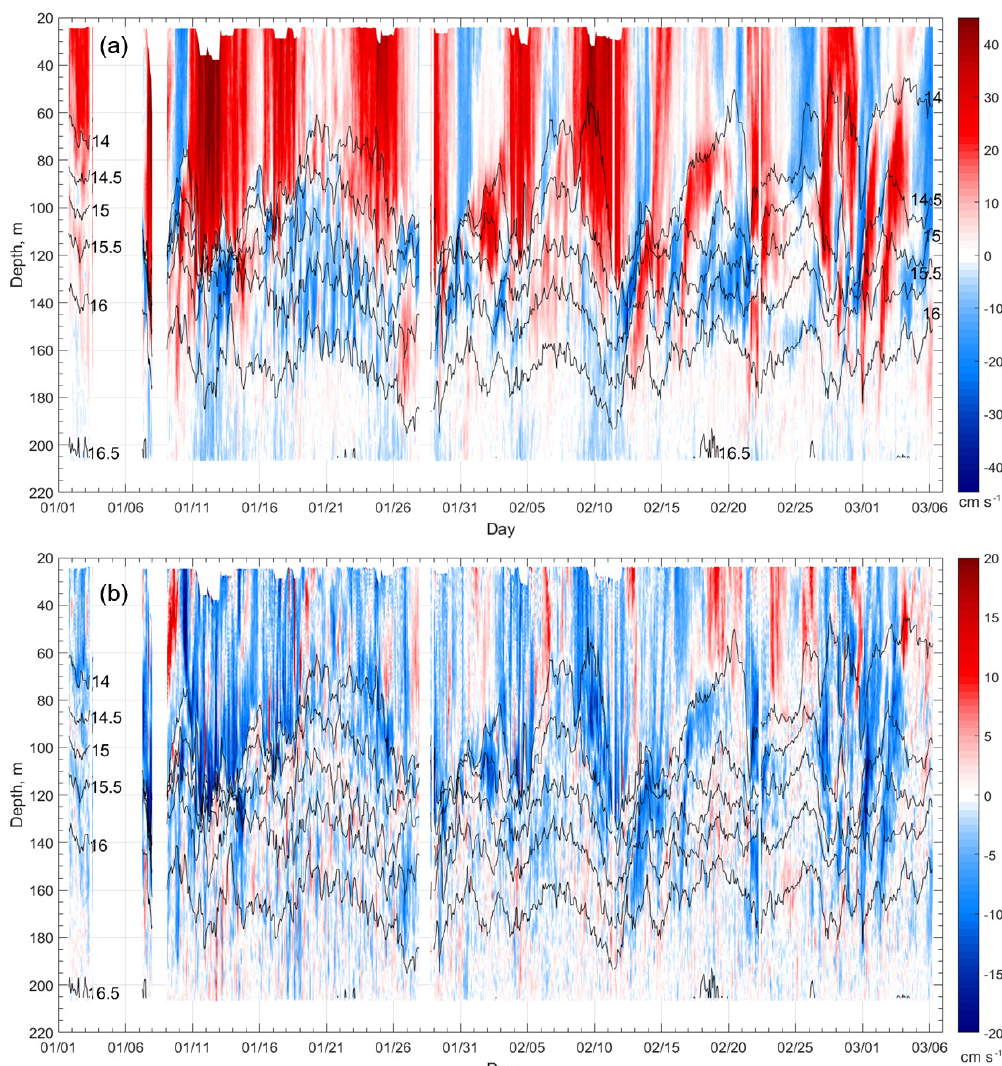
Figure 3. Profiles of along-shore (a) and cross-shore (b) components of the current velocity, depicted as colored contours. The isopycnals σ (cid:50) are superimposed (black lines). Note that the positive direction of the along-shore axis is 320 ◦ , and the positive direction of the cross-shore axis is 50 ◦